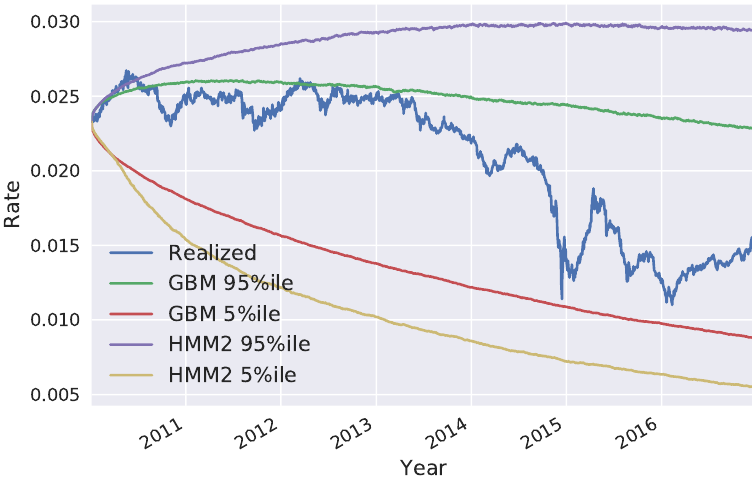
Figure 9. Percentiles of long-term distribution cones for RUB/EUR under GBM and HMM with two states.